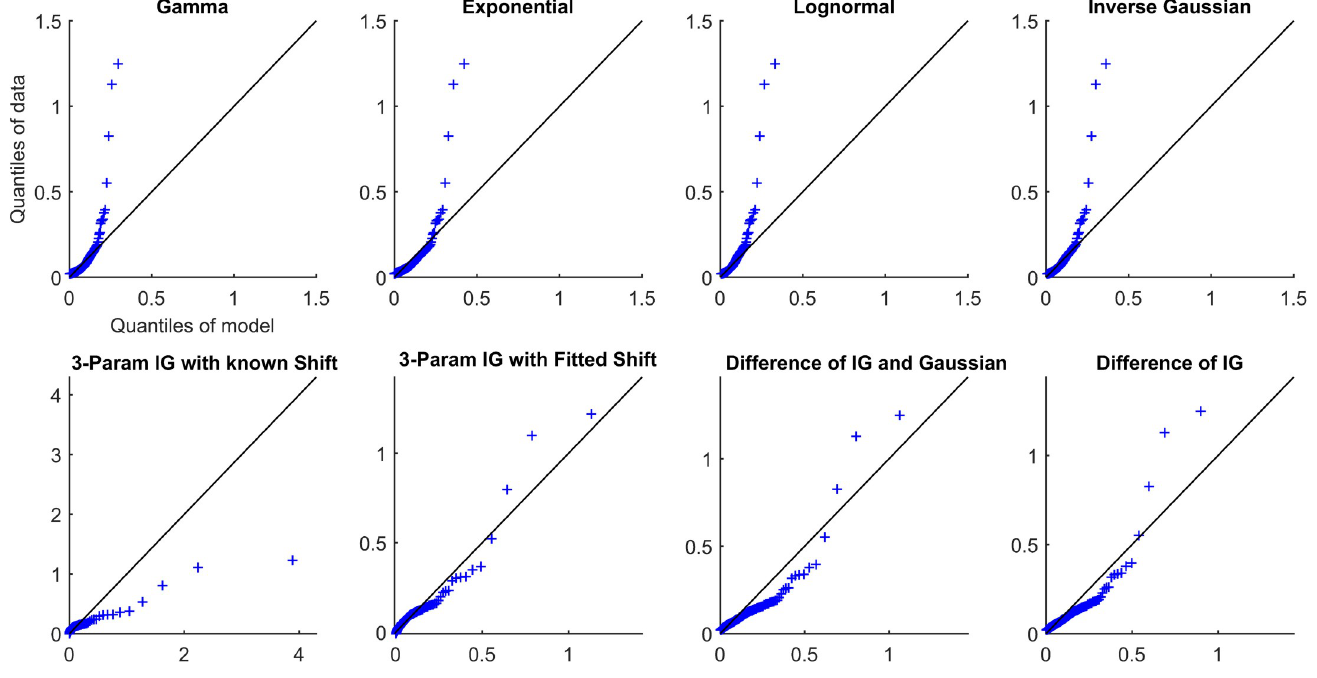
Fig 4. QQ plots for Subject P10 from the propofol sedation cohort.